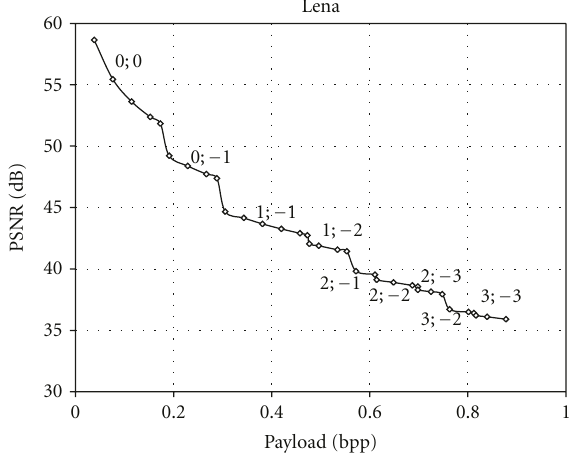
Figure 3: Appropriate threshold values for Lena